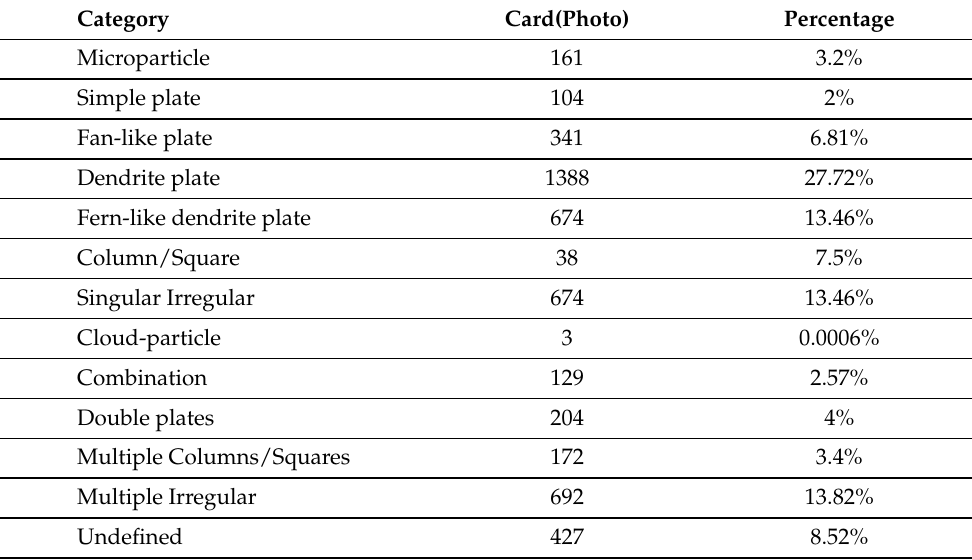
Table 2. The 5K EPP dataset